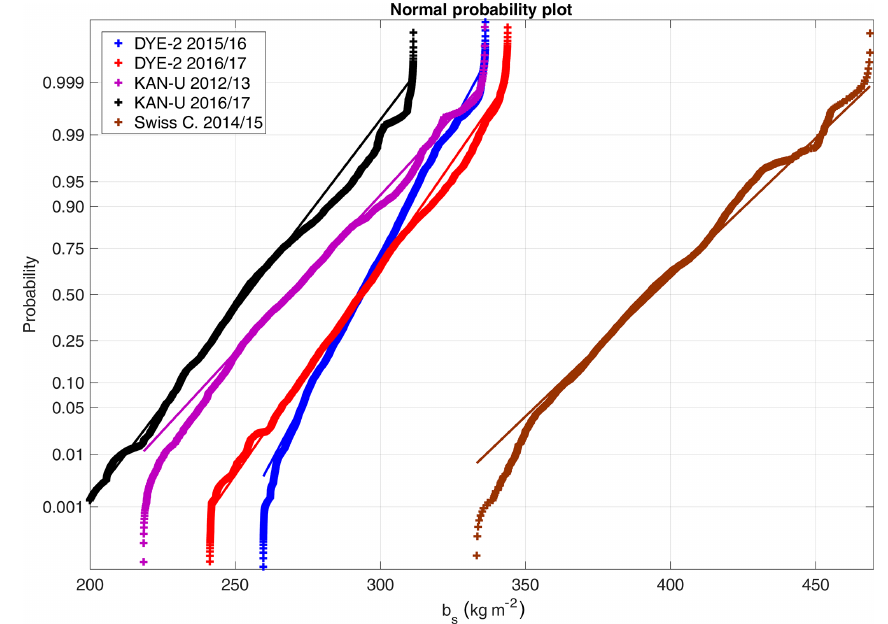
Figure 3. Normal probability plots displaying deviations from a standard normal distribution (straight line with corresponding color). The crosses plot the empirical probability versus the data value for each radar-determined b s value. We display smoothed transects values for KAN-U and DYE-2 and solely vertical-sampling-corrected values for Swiss Camp. Table 3. Kriging results with description of correlation ranges for the major and minor axes used in the variogram modeling, the resulting